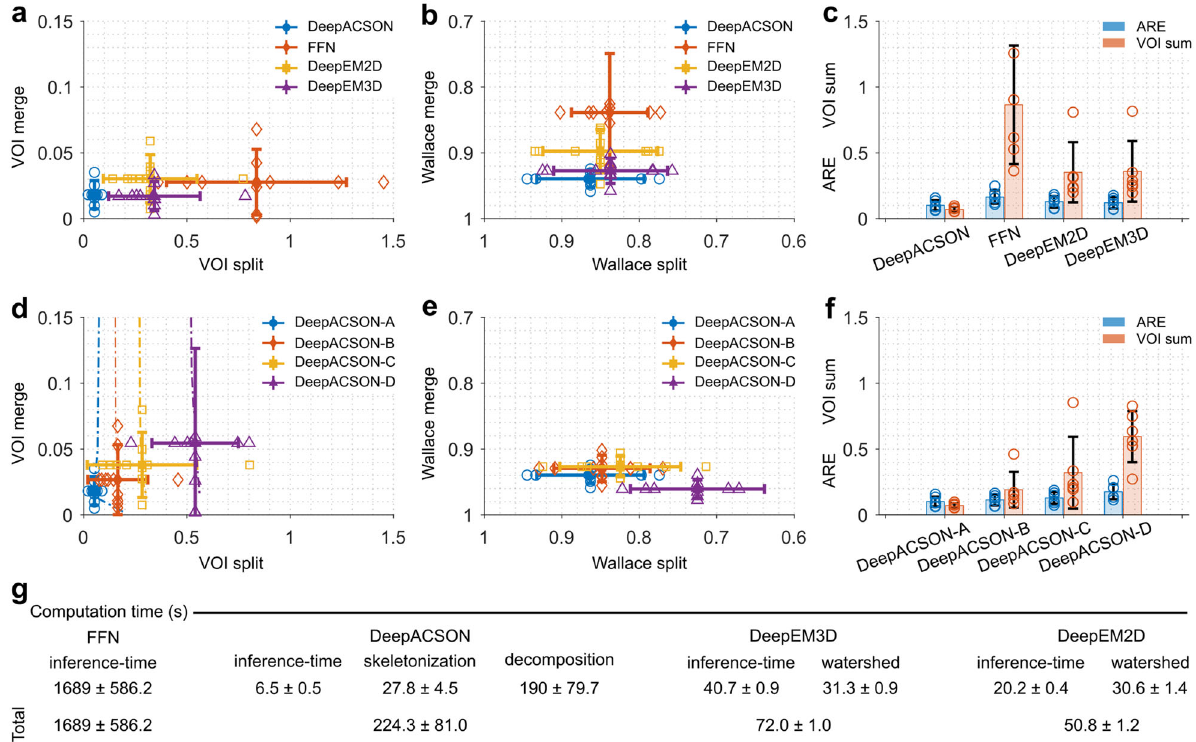
Fig. 6 DeepACSON quantitative evaluations. Comparison of DeepACSON against state-of-the-art segmentation methods, DeepEM2D, DeepEM3D, and FFN, using a variation of information (VOI, split and merge contribution, lower value is better), b Wallace indices (split and merge contribution, higher value is better), and c adapted Rand error (ARE, lower value is better) and the sum of VOI split and VOI merge (VOI sum, lower value is better). DeepACSON outperformed other techniques as it produced the smallest VOI split, VOI merge, VOI sum, and ARE, and the biggest Wallace split and merge values. Comparison of the design parameters of DeepACSON: standard DeepACSON (DeepACSON-A), a U-Net with residual modules (DeepACSON-B), the effect of BM4D denoising (DeepACSON-C), and adjusting the resolution between the training and test sets (DeepACSON-D) over d VOI (split and merge contribution) e Wallace indices (split and merge contribution), and f ARE and VOI sum. The fi lled-circles and error bars show the mean and standard deviation of the evaluations, respectively. The dash-dotted lines show the choice of binarization threshold. The comparisons were run over the best threshold, i.e., smallest VOI merge and VOI split. g Comparison of the computation time of DeepACSON against DeepEM2D/3D and FFN (mean ± standard deviation). All comparisons were run over six test SBEM datasets of size 290 × 290 × 285 voxel 3 , automatically segmented using the ACSON pipeline 5